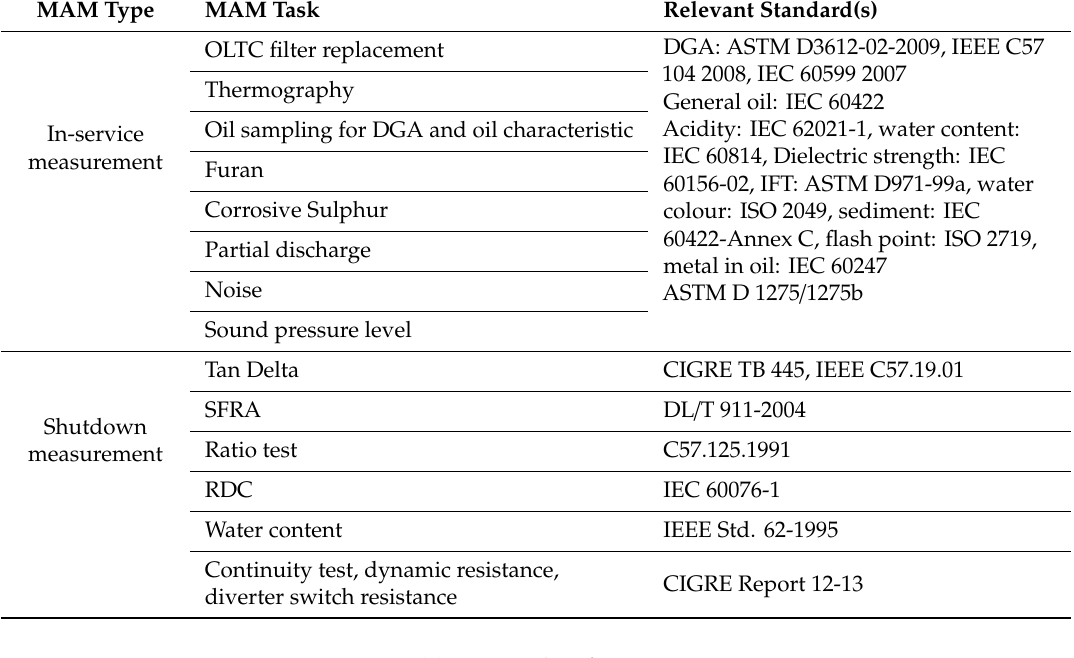
Table A1. Some relevant industrial standards for PT health monitoring.